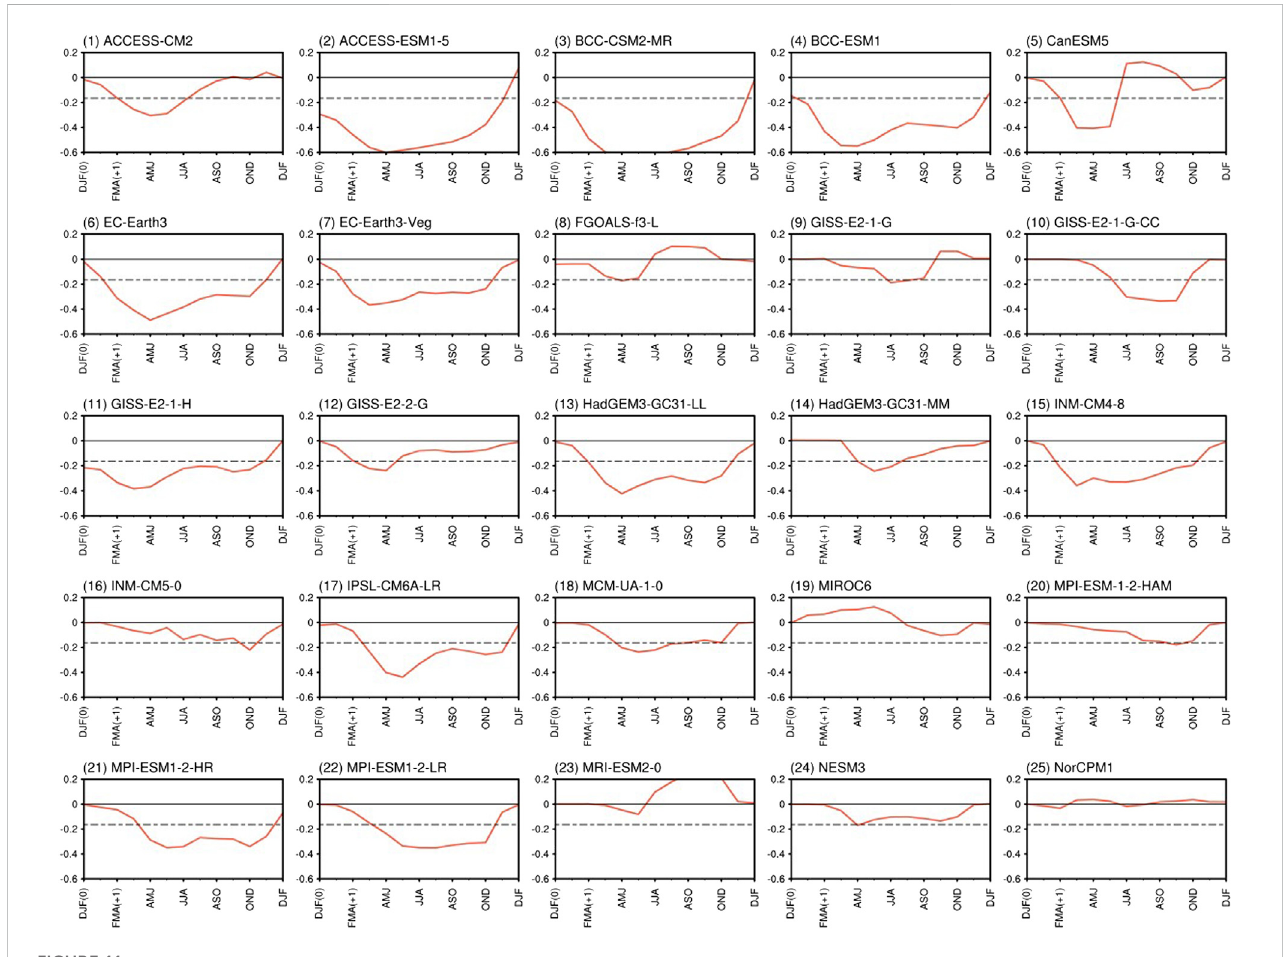
FIGURE 11 Lead-lagcorrelationsoftheDJFM(0)-averagedNADIwith3-month-averagedAWPAIderivedfromtheCMIP6modelsimulations.Thehorizontaldashed lines show the 90% con fi dence